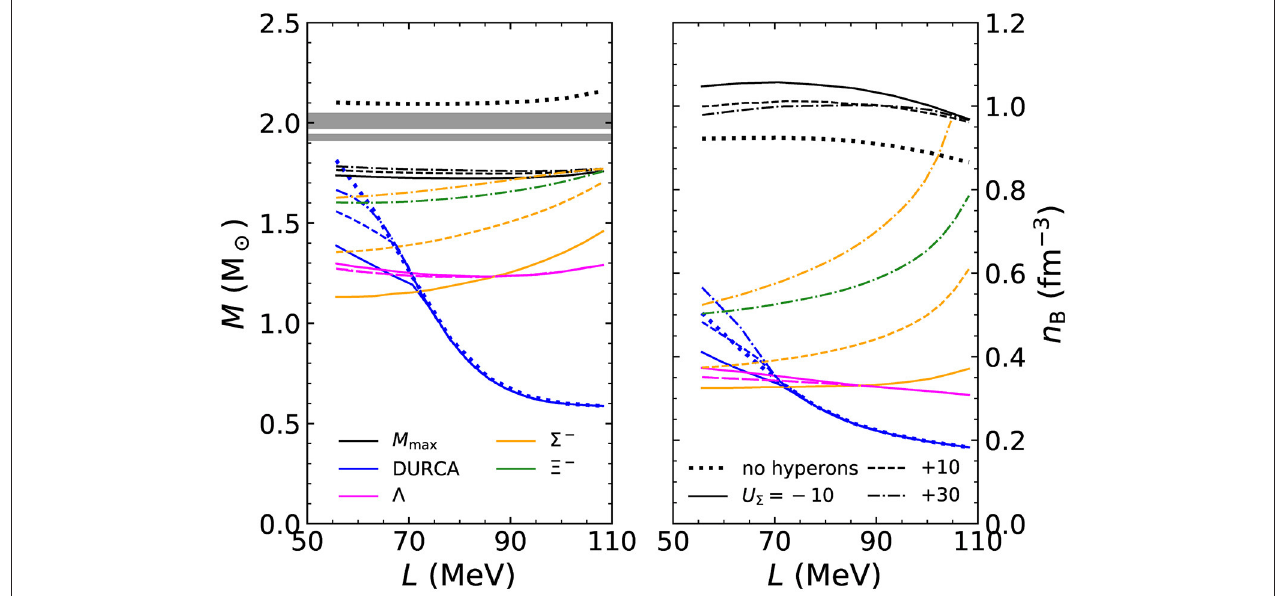
10, 10, and 30 MeV) as a function of the slope of −